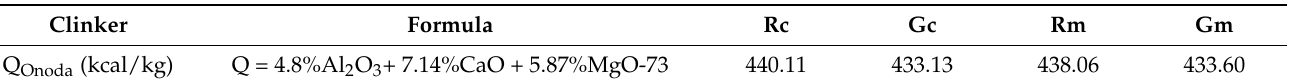
Table 4. Heat of reaction (calculated with Onoda formula) for the studied raw